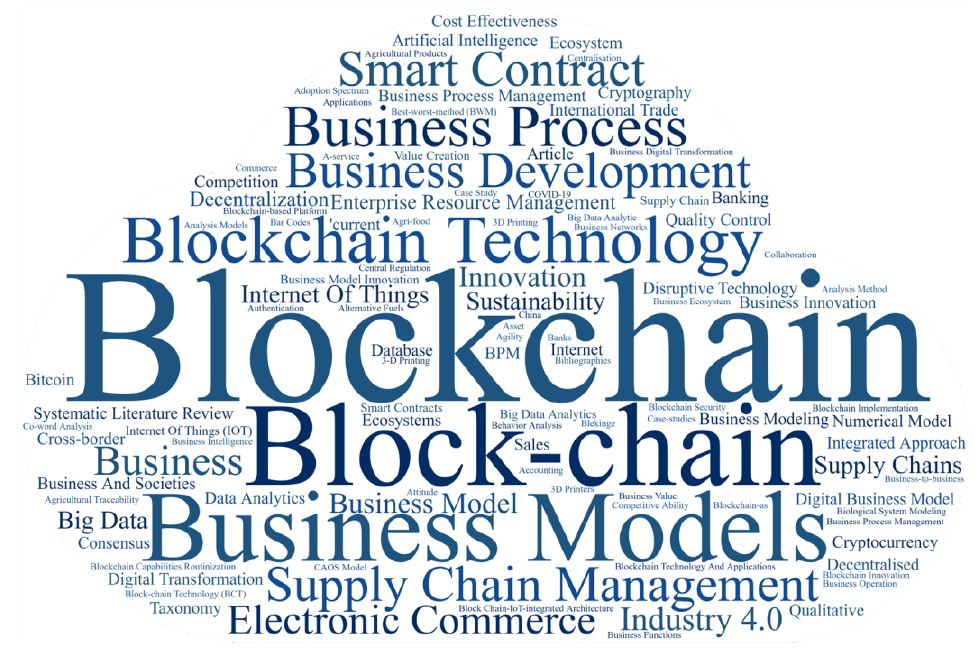
Figure 4. The primary keywords used in the articles.